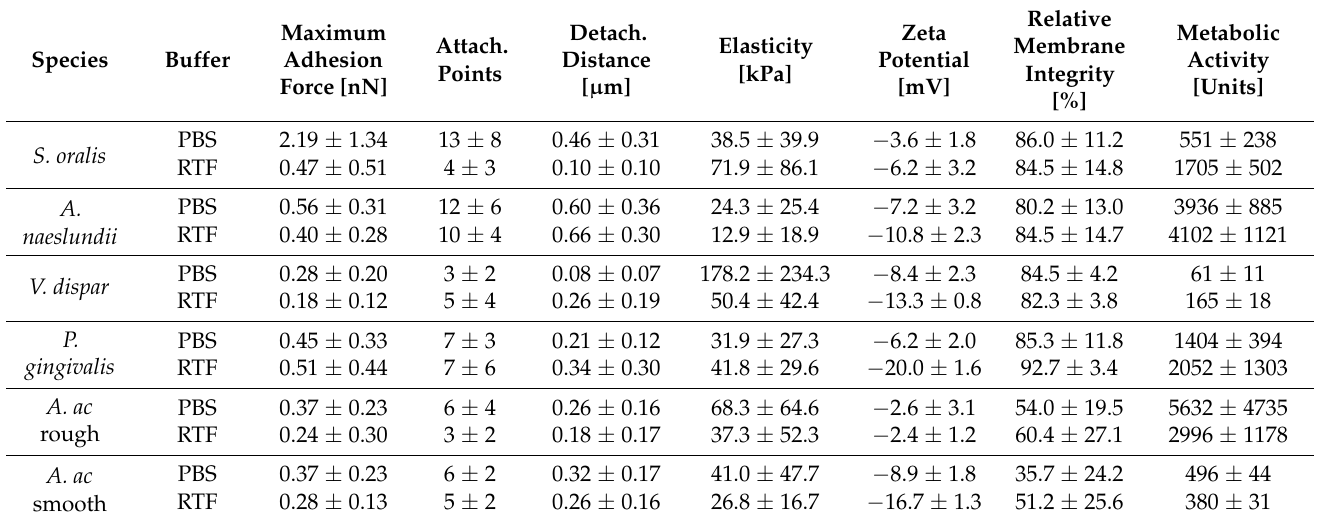
Table 2. Summary of parameters analyzed for bacterial strains in different buffer conditions as mean ± standard